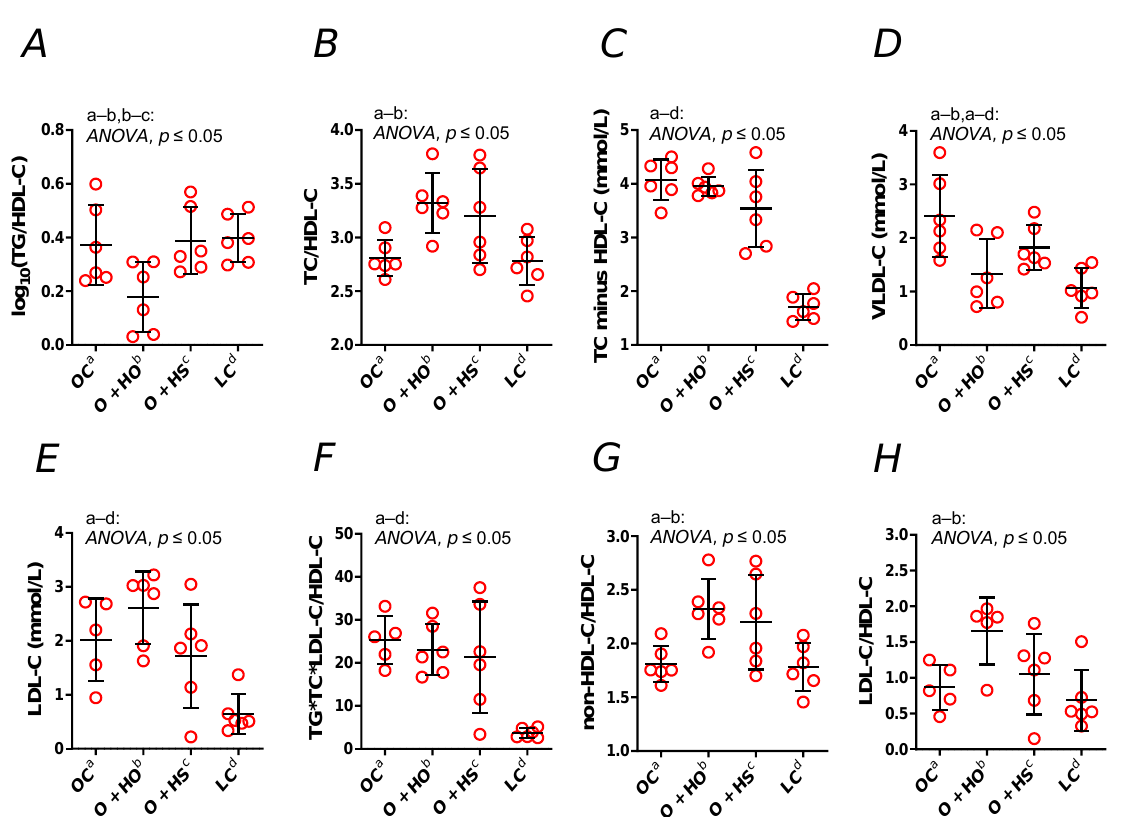
Figure 3. A nontraditional lipid profile ( A – H ) of 8-week-old lean (LC) and obese (OC) Zucker rats fed a diet containing hemp seed oil (HO) and hemp seeds (HS) for 4 weeks. Values are means ± SD, n = 6, p ≤ 0.05 (two-way ANOVA). HO decreased the calculated atherogenic parameters; meanwhile, HS had no such effect.